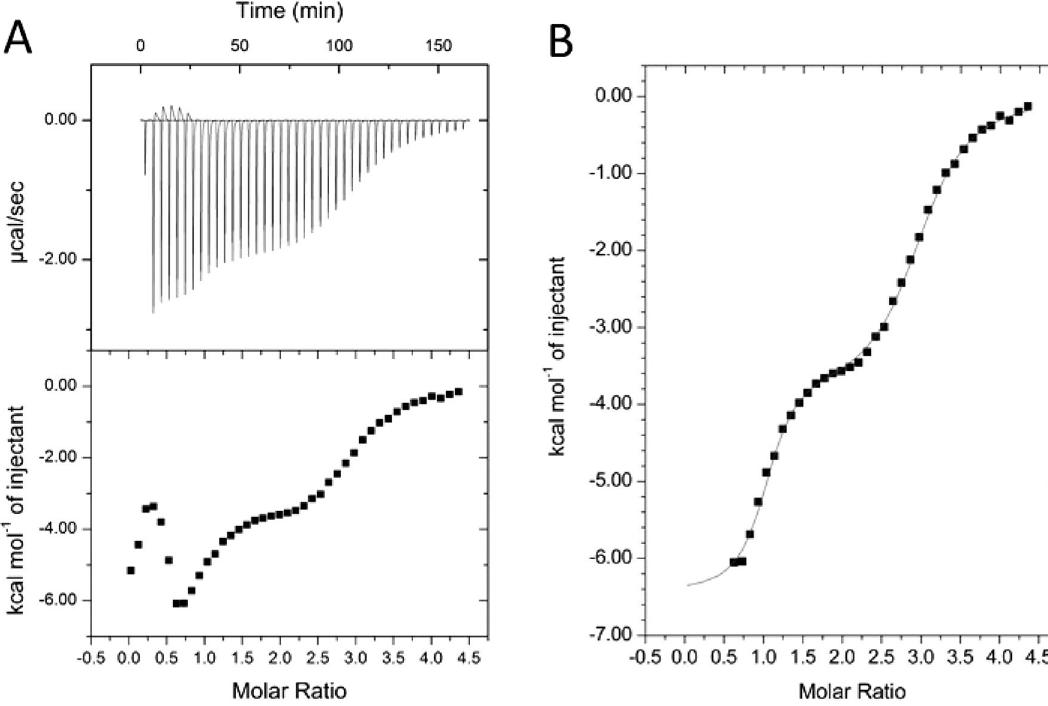
Figure 3. ITC results on the determination of the K d values of FliC-NikR C binding sites in solution. ( A ) Raw (top) and integrated (bottom) thermograms. ( B ) The measured data points were fitted by the “Sequential Binding Sites” model (MicroCal) assuming 3 Ni-binding sites.